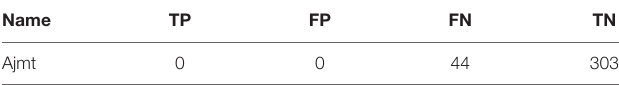
TABLE 7 | ROC values for the randomized EQ catalog—Ajameti